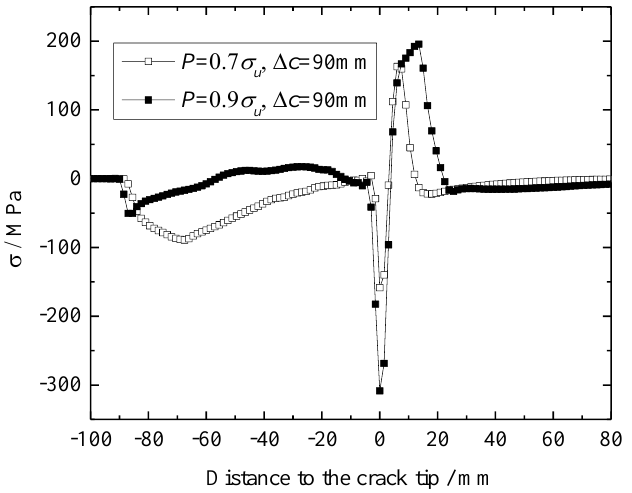
Figure 12. Stress distribution curve of the crack tip at different load levels for crack propagation length ∆𝑐 = 90 mm .